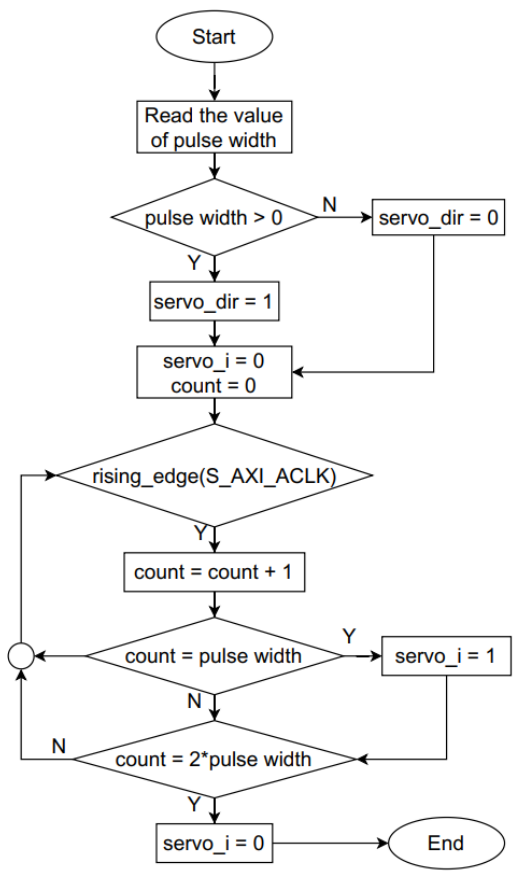
Figure 6. Pulse generation